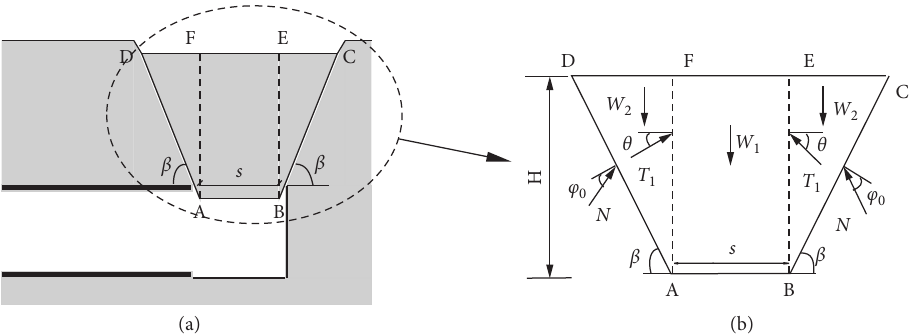
Figure 4: Calculation diagram for stability analysis of the arch crown. (a) Failure mode. (b) Calculation diagram.